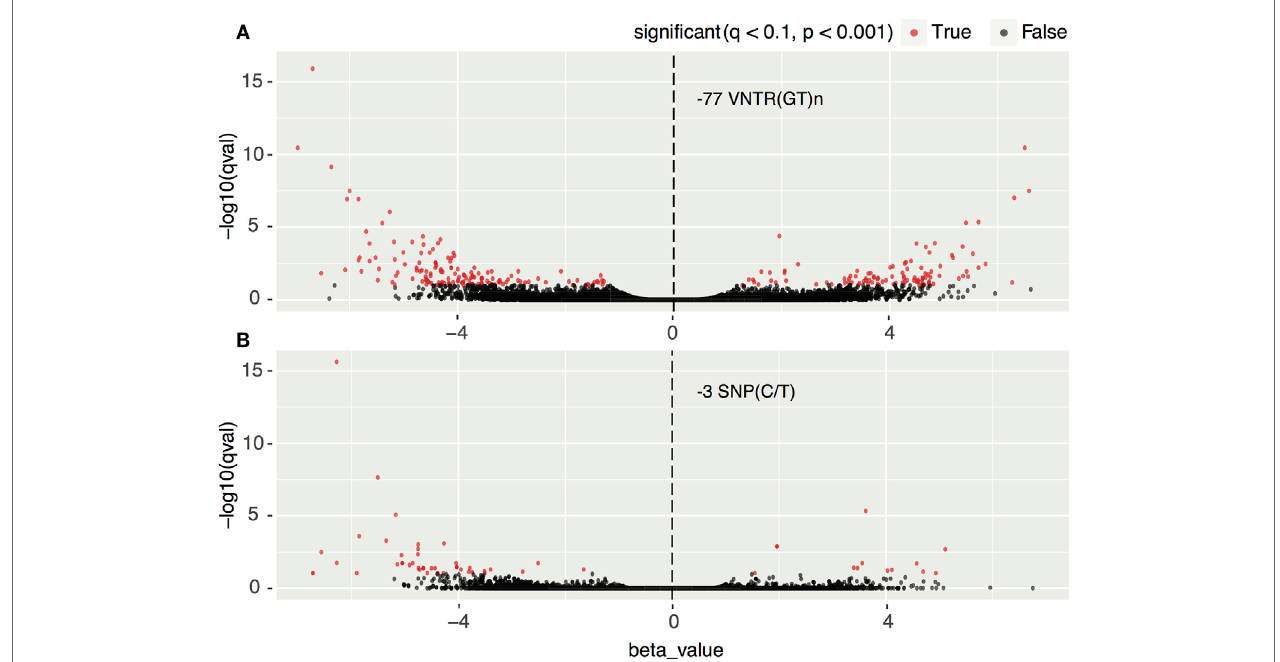
FigUre 3 | Impact of (a) − 77 VNTR (GT)n and (B) − 3SNP C/T on the hepatocellular carcinoma transcriptome. Transcripts with statistically significant change in their expression are in red. Positive and negative normalized beta values correspond to up- or downregulation, respectively. There are approximately four times more significantly differentially expressed transcripts in the − 77 VNTR (GT)n compared to the − 3SNP C/T genotype